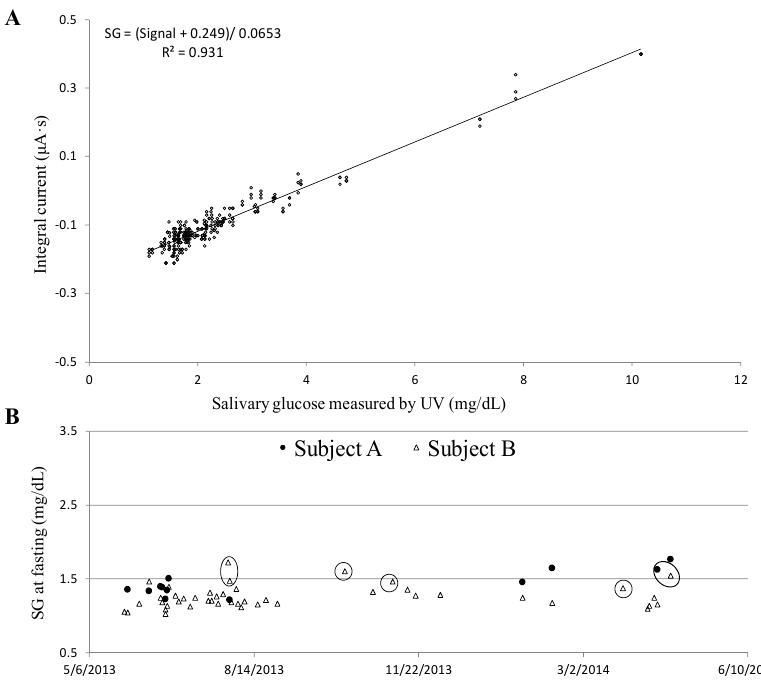
Figure 7. ( A ) Linear correlation between sensor and ultra-violet visible (UV) measured salivary glucose (SG) with obtained conversion formula; ( B ) Fasting SG monitoring history of two healthy females. Table 3. Ten healthy subjects’ blood glucose (BG)/salivary glucose (SG) ratios at fasting.